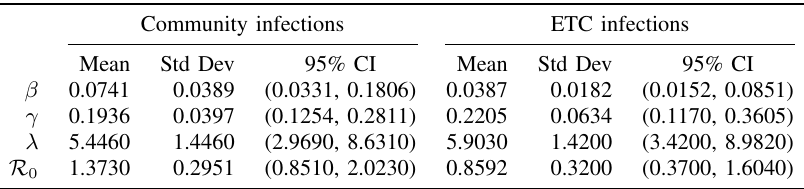
TABLE I: Results under the EVD branching process model for the community and ETC outbreaks Community infections ETC infections